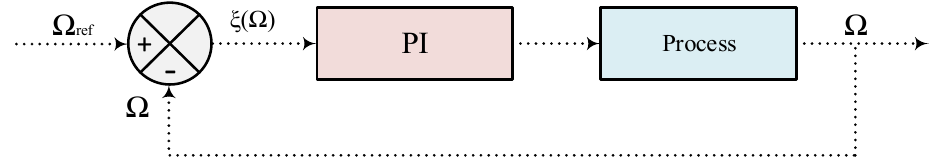
Figure 3. The diagram block of speed PI controller.